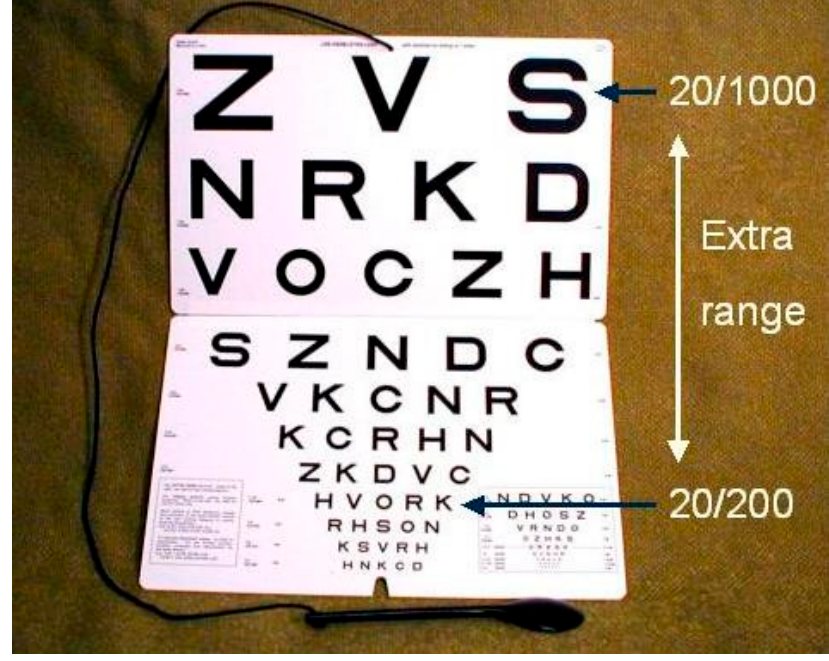
Figure A3. Extended range of a 1-m chart. The chart extends the range by seven lines.